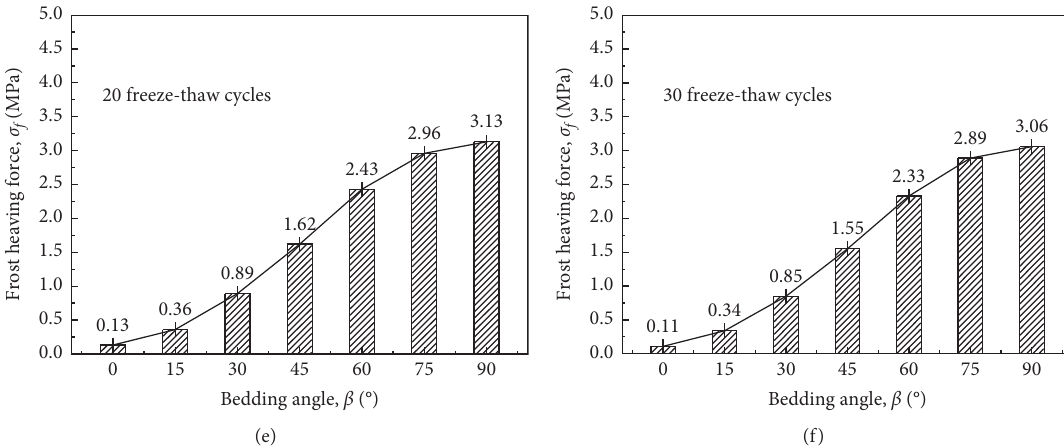
Figure 6: Maximum frost heaving force in cold-region tunnels after different numbers of F-Tcycles. (a) After 0 F-Tcycles. (b) After 5 F-T cycles. (c) After 10 F-T cycles. (d) After 15 F-T cycles. (e) After 20 F-T cycles. (f) After 30 F-T